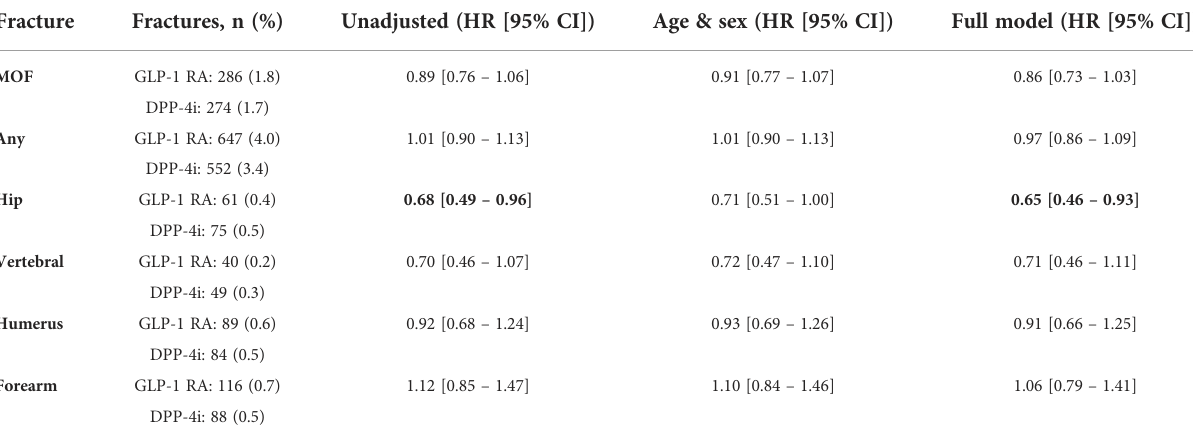
TABLE 2 Hazard Ratios (HR) for various fracture types in the matched